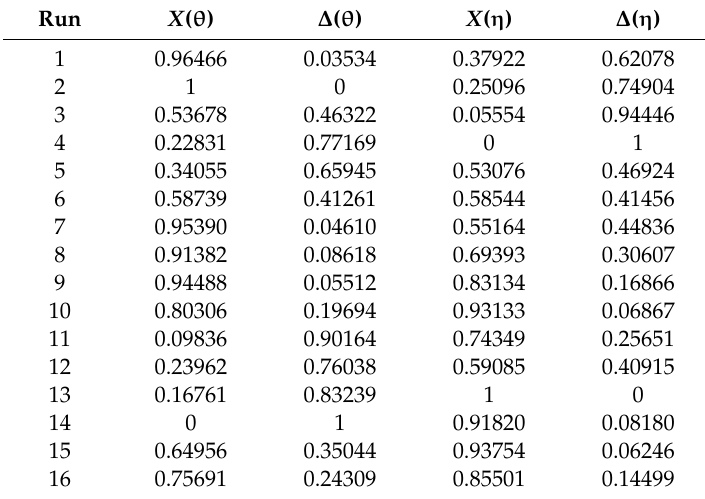
Table 6. Original experimental data after normalization and the corresponding